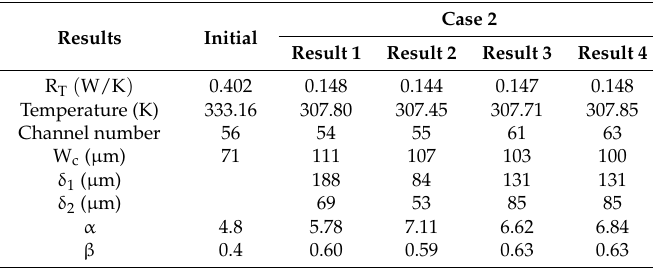
Table 4. Optimal results of the single objective function in Case